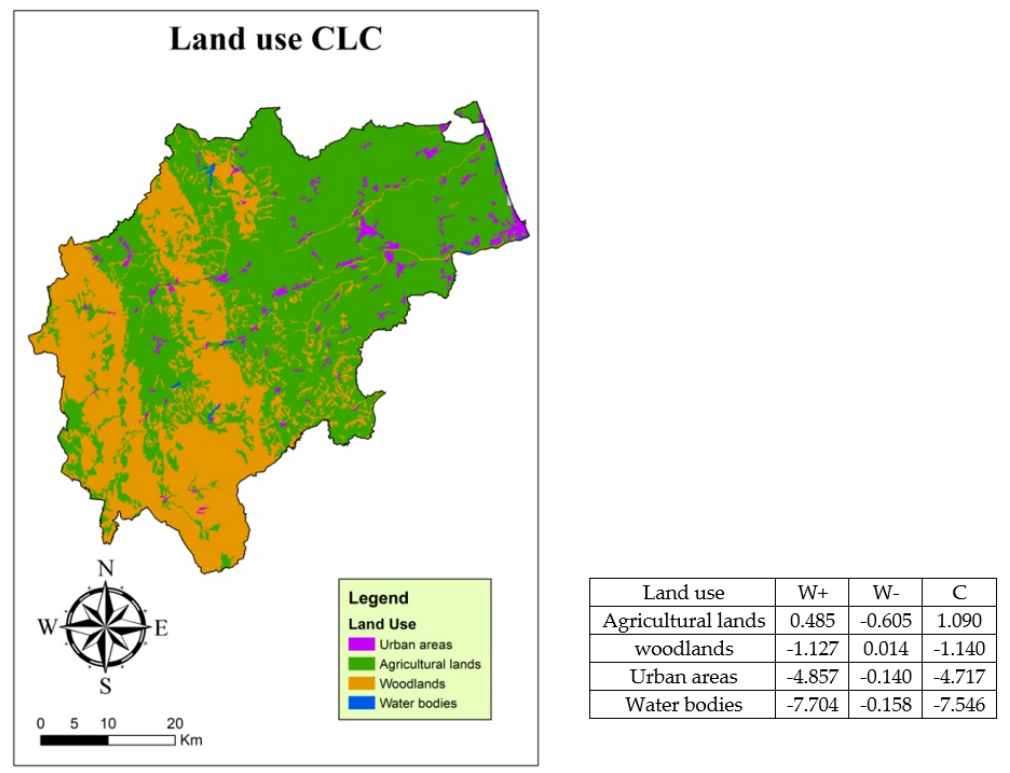
Figure 7. ( Left ) Land use of Macerata province, from Corinne Land Cover; ( Right ) The weights calculated for the land use